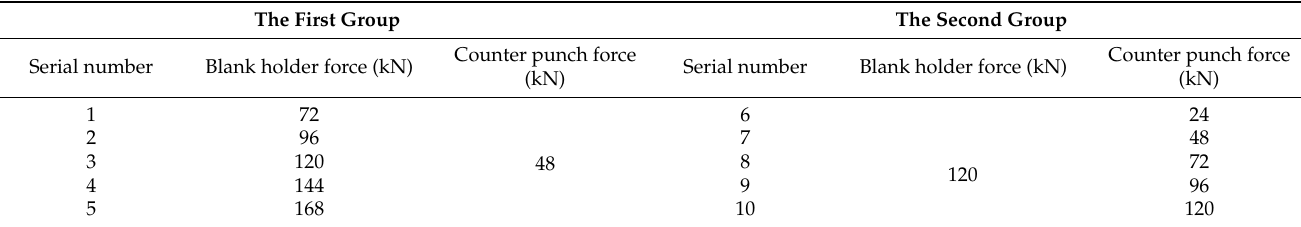
Table 4. Finite element simulation design table.